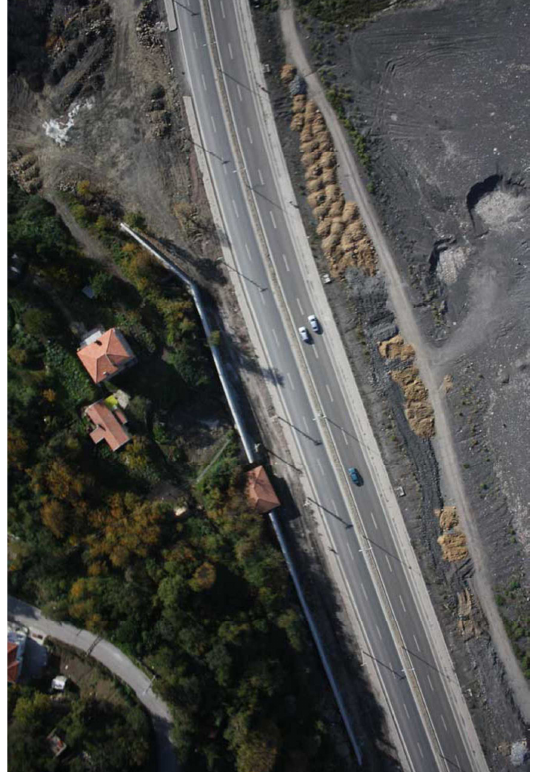
Figure 6 Sample for Road Details